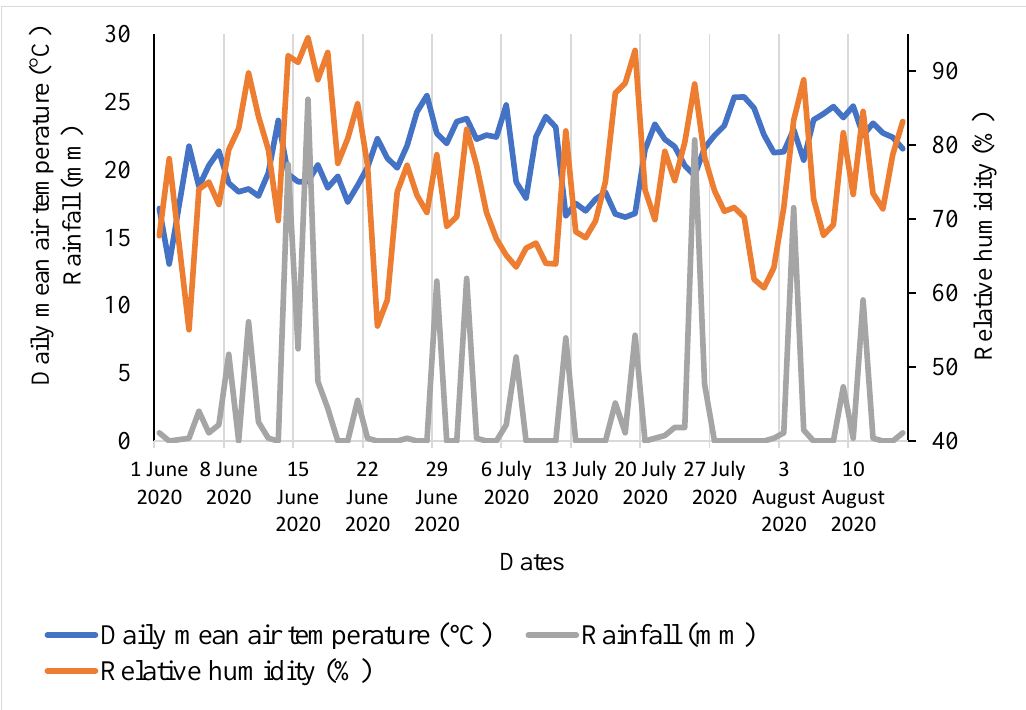
Figure 1. Daily mean air temperature (°C), rainfall (mm), and relative humidity (%) of the experi- Figure 1. Daily mean air temperature ( ◦ C), rainfall (mm), and relative humidity (%) of the experi-